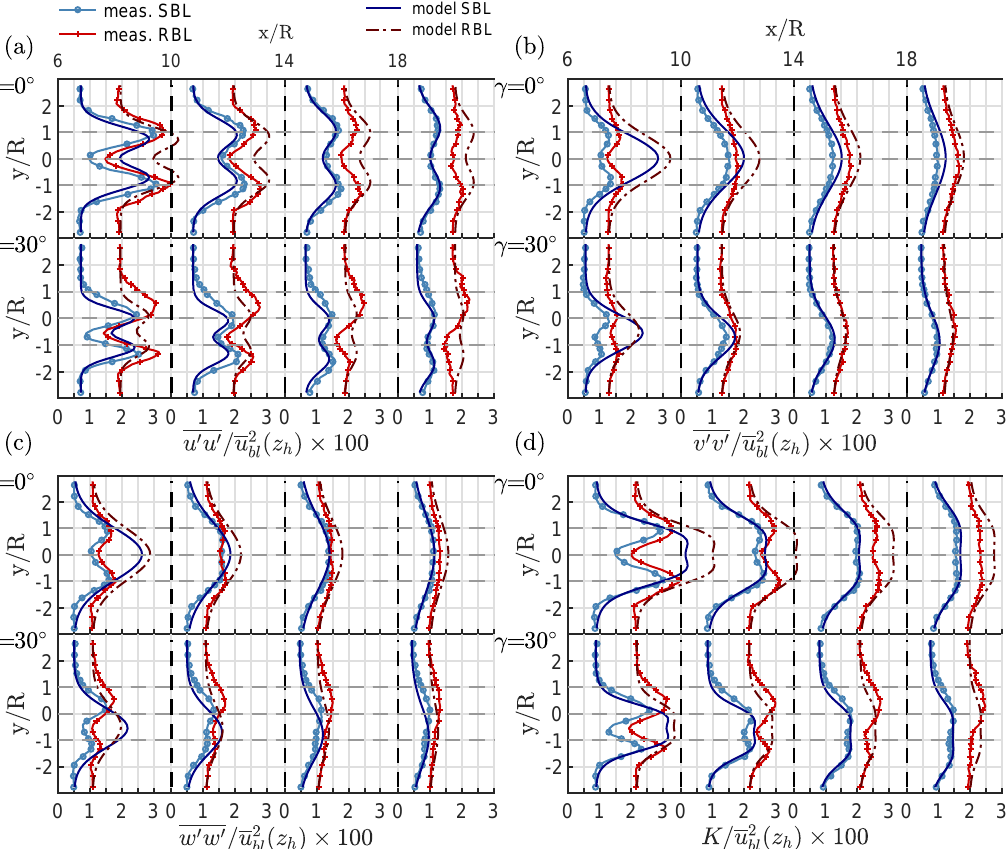
Figure 16. Comparison of model predictions ( lines ) and measurement results ( symbols and lines ) in the horizontal plane at hub height z h for the Reynolds stress components ( a ) u (cid:48) u (cid:48) , ( b ) v (cid:48) v (cid:48) and ( c ) w (cid:48) w (cid:48) , and ( d ) the turbulent kinetic energy K , all normalised by u 2